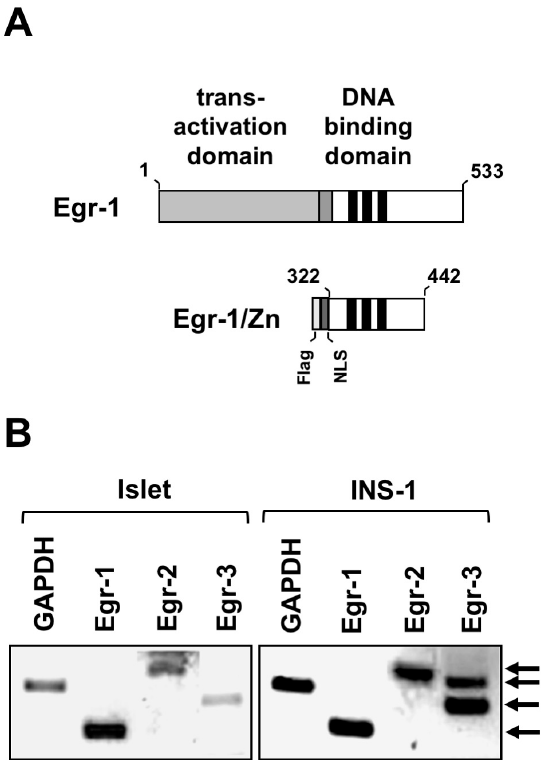
Figure 2. Domain structure of Egr-1 and Egr-1/Zn and expression of Egr proteins in pancreatic β - cells and insulinoma cells. ( A ) Domain structure of Egr-1 and Egr-1/Zn. The DNA binding domain of Egr-1 encompasses three zinc finger motifs. The activation domain is located N-terminal. Binding sites for NAB1 and NAB2, two negative cofactors, are adjacent to the DNA binding site. Egr-1/Zn is a truncated version of Egr-1, encompassing only the DNA binding domain. ( B ) Expression of the Egr proteins (Egr-1-3) in pancreatic islets and INS-1 insulinoma cells. Expression was detected by RT-PCR. As a control, GAPDH mRNA expression is depicted. Reproduced with modifications from ref. [10] with permission from Oxford University Press.